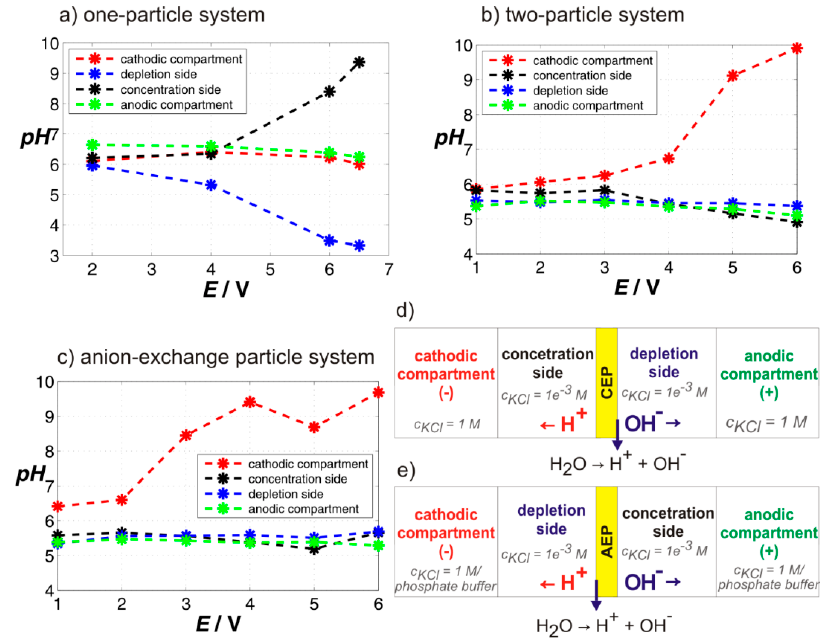
Figure 5. pH changes in the solutions taken from individual chambers of the cell after running chronoamperometric measurement for 5 min. The graphs ( a ) and ( b ) are for one- and two-particle membranes studied here, graph ( c ) for an anion-exchange resin particle serving as a control system. The schematics ( d ) and ( e ) depict the situation which would occur in a cation- and anion-exchange system with the proceeding water splitting reaction, respectively.